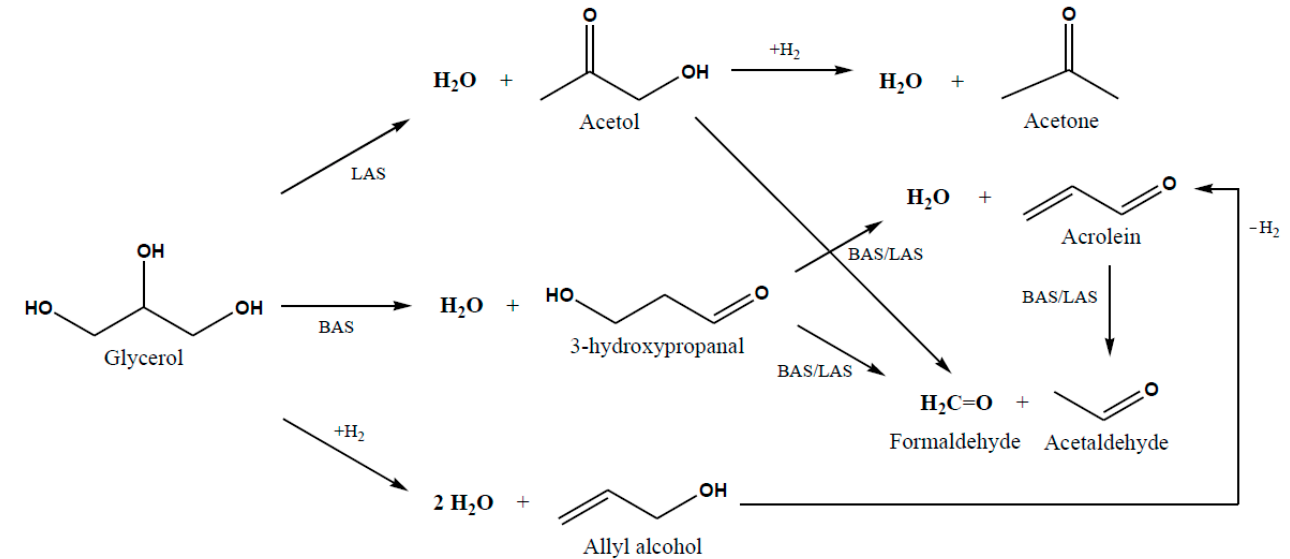
Figure 7. Glycerol dehydration reaction routes over HY zeolites.